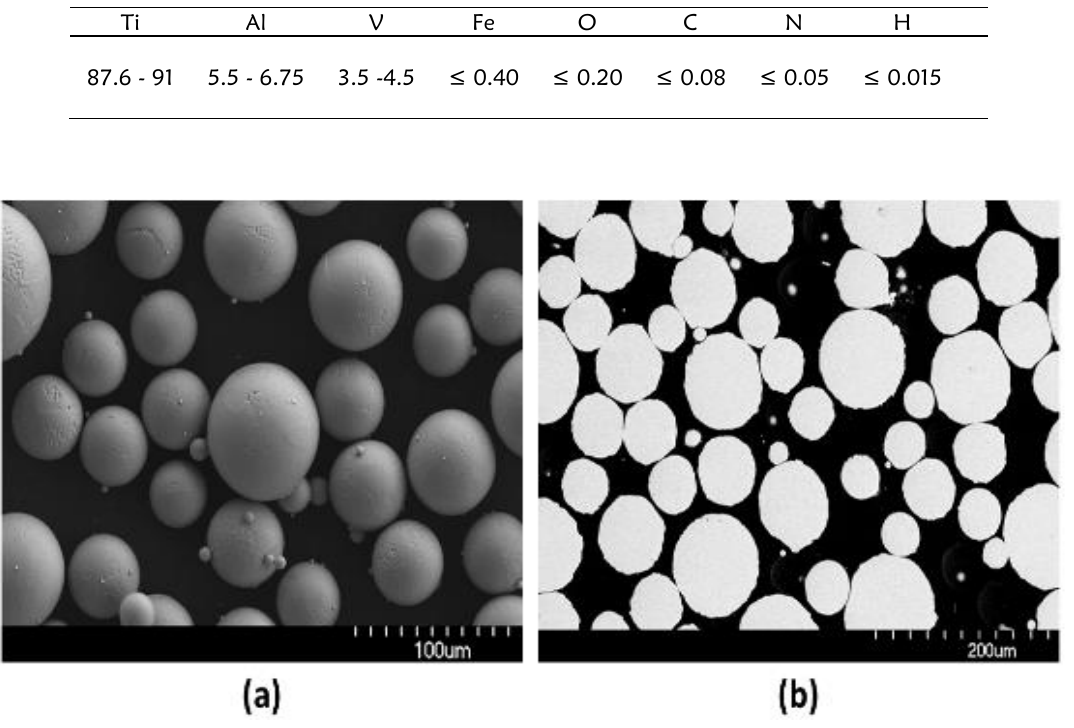
Figure 1: Ti6Al4V Powder (a) Morphology; (b) Metallographic image